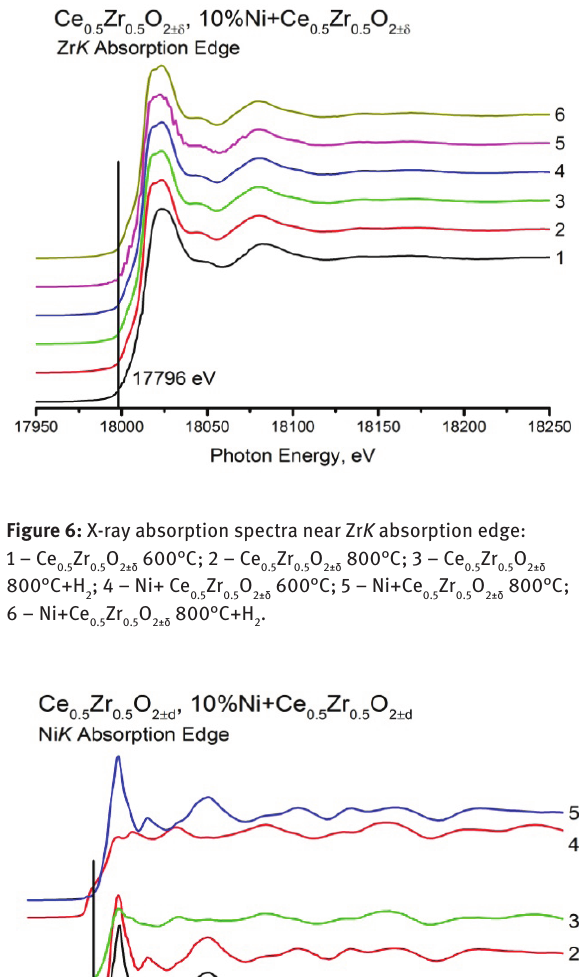
absorption edge: Figure 5: X-ray absorption spectra near Ce L III 1 – Ce Zr O 600°C; 2 – Ce Zr O 800°C; 3 – Ce Zr O 0.5 0.5 2±δ 0.5 0.5 2±δ 0.5 0.5 2±δ 800°C+H ; 4 – Ni+ Ce Zr O 600°C; 5 – Ni+Ce Zr O 800°C; 2 0.5 0.5 2±δ 0.5 0.5 2±δ 6 – Ni+Ce